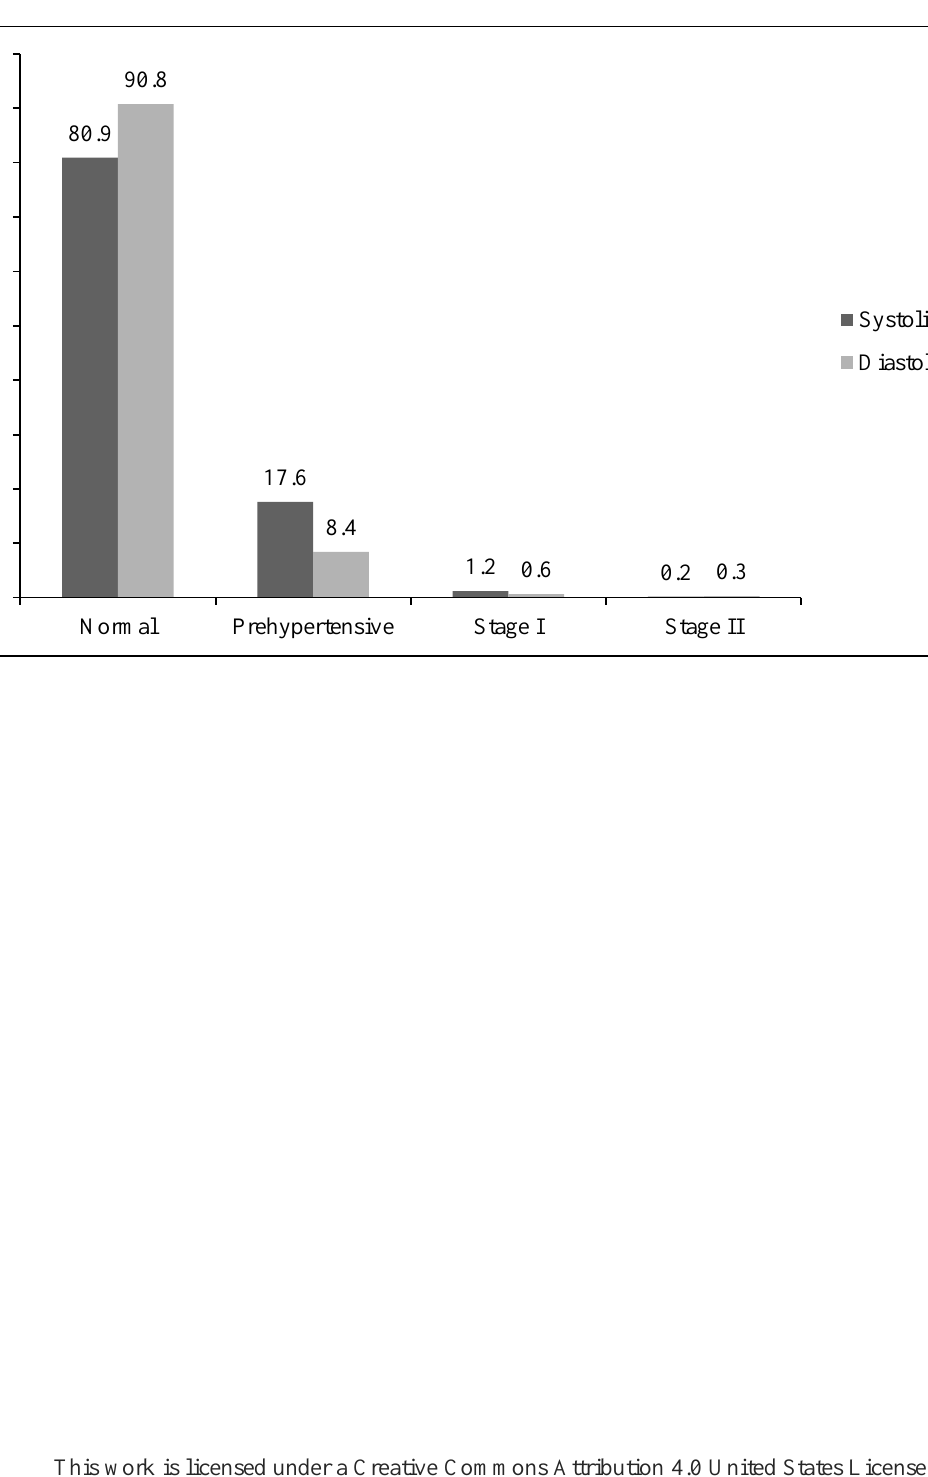
Figure 1: Distribution of stages of hypertension among antenatal women at